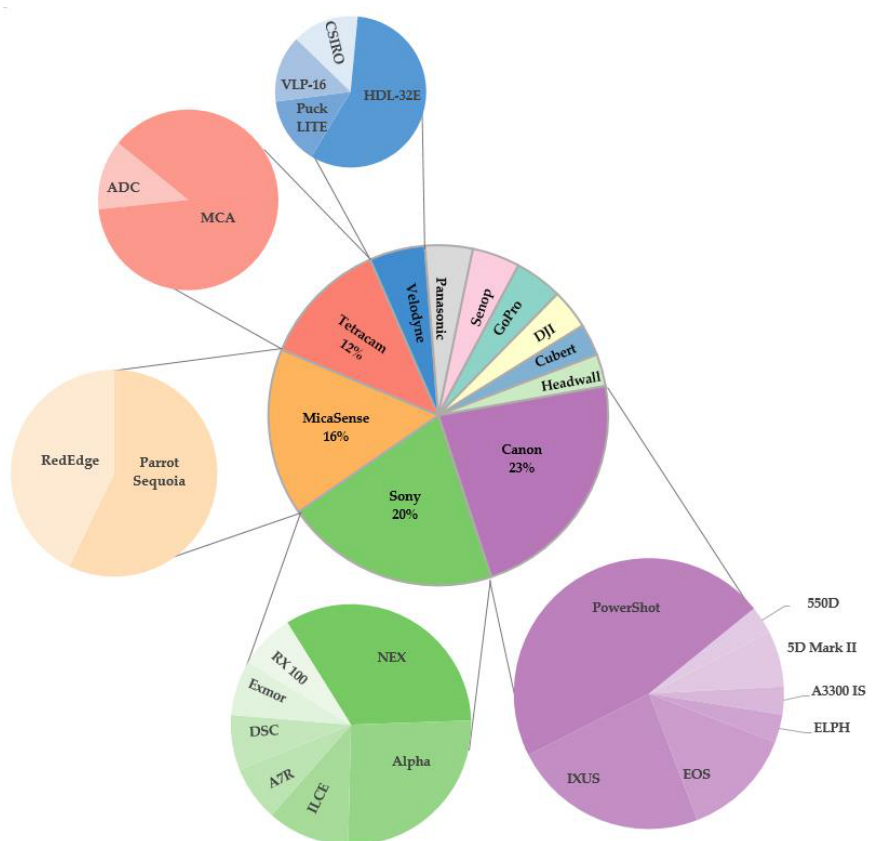
Figure 10. Preferred brands of sensors used in the surveyed studies with percentages and values for each brand.